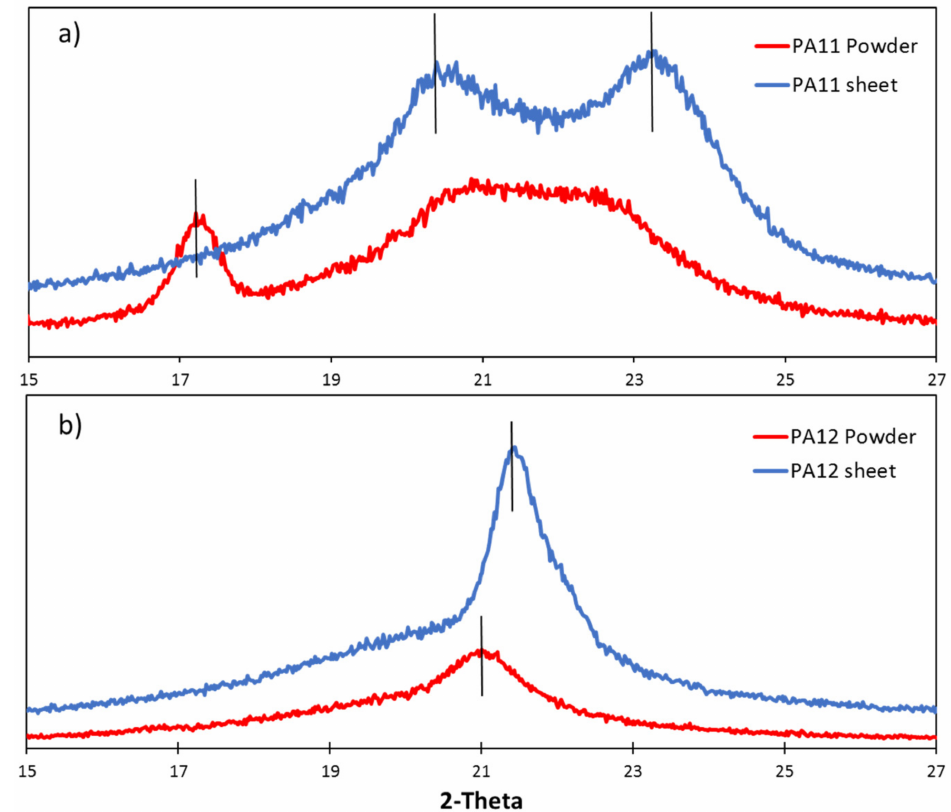
Figure 9. XRD patterns for PAs in the form of powder and sheets: ( a ) PA11, ( b ) PA12.